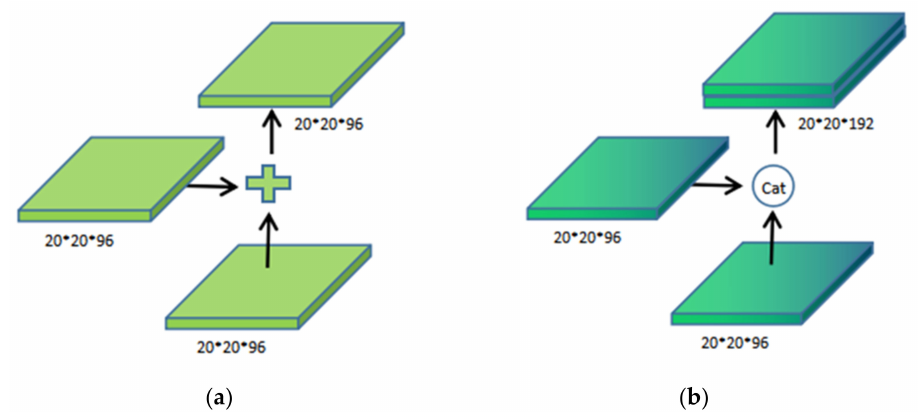
Figure 5. Comparison of neck with PAN structure. ( a ) Improved neck PAN structure. ( b ) PAN structure in